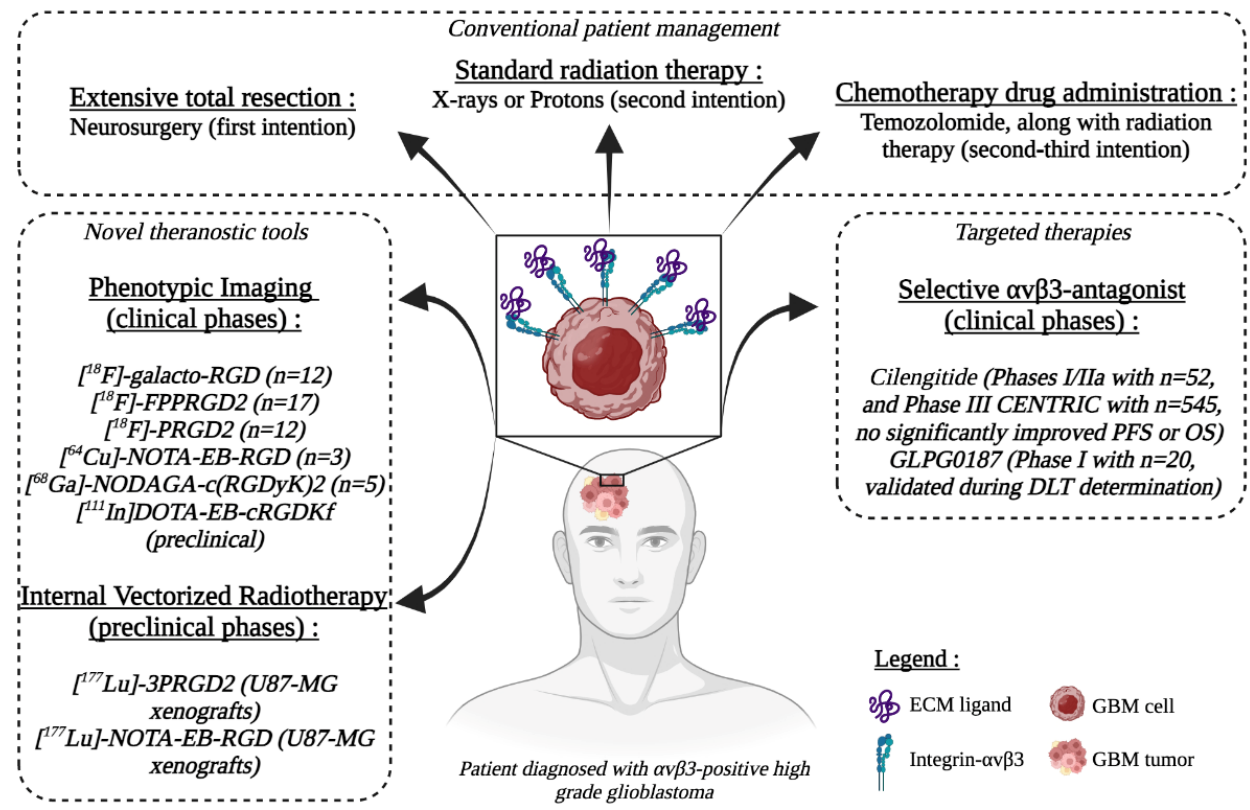
Figure 1. This panel depicts the standards of care for patients diagnosed with glioblastoma, from neurosurgery to radiation therapy, combined or not with chemotherapy. Current innovative tools in clinical phases for theranostics are listed. This illustration was created with BioRender (BioRen- der.com, accessed on 1 April